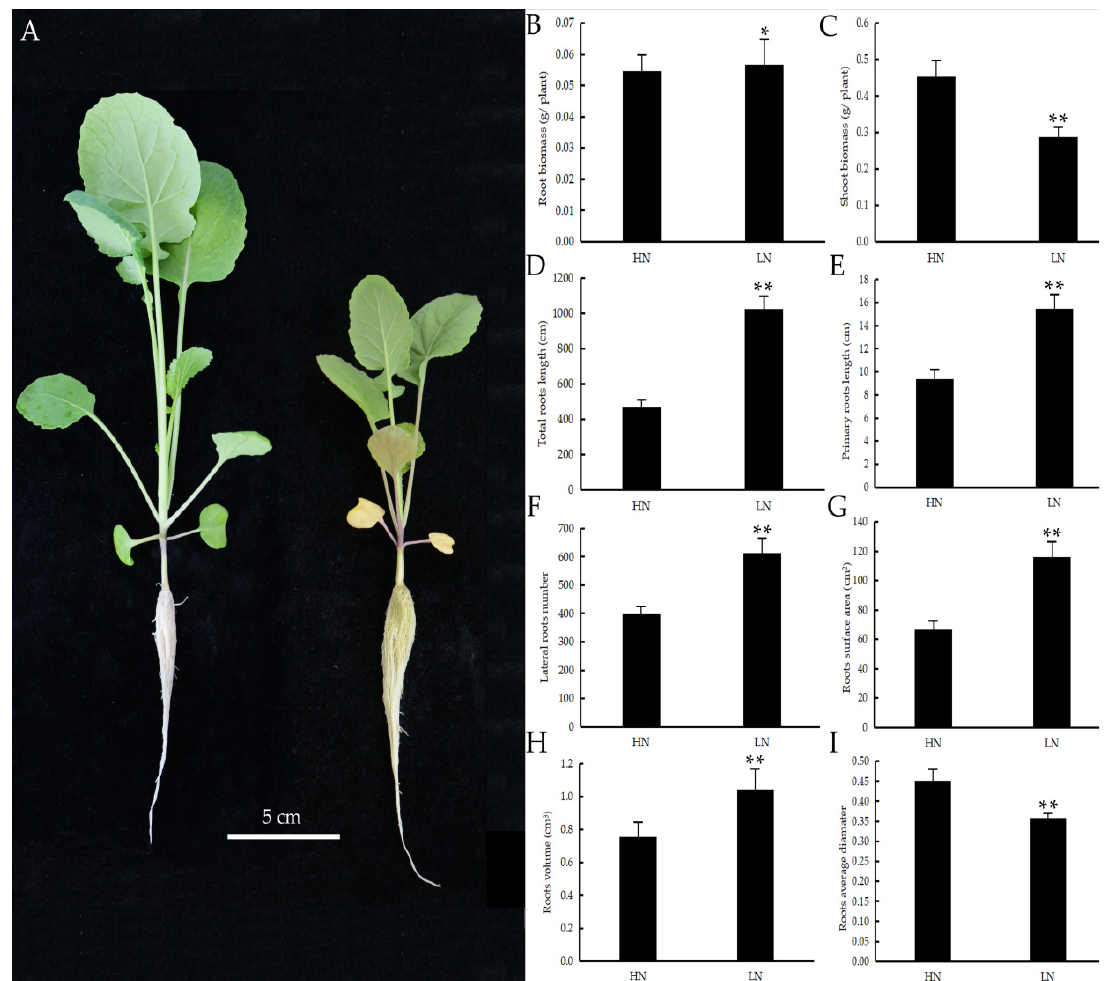
Figure 1. Phenotypic characterizations of rapeseed under HN and LN treatment. ( A ) Phenotypes of rapeseed seedlings under HN and LN treatment; root biomass ( B ), shoot biomass ( C ), RL ( D ), primary root length ( E ), lateral root number ( F ), root surface area ( G ), root volume ( H ), and RD ( I ) of rapeseed seedlings under HN and LN treatment. Each point represents the mean value of three independent experiments performed in triplicate + the SE. Statistically significant differences were assessed using Student’s t -test (* p < 0.01; ** p < 0.005).